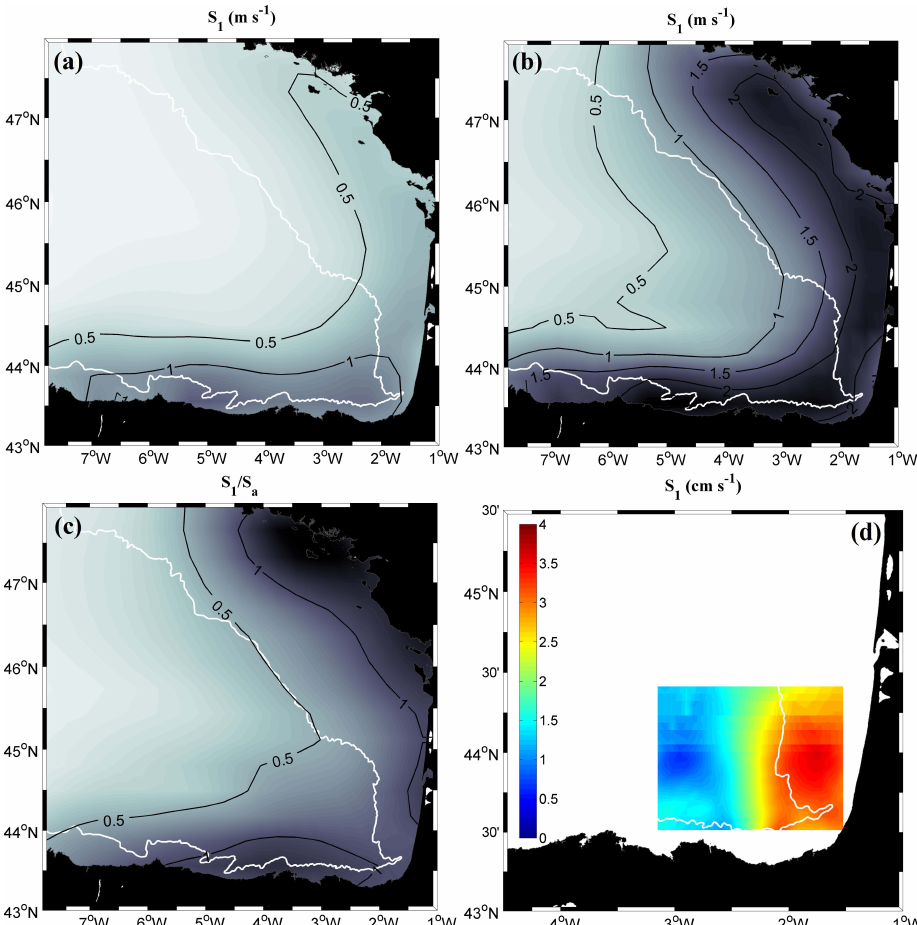
Fig. 3. The amplitude (ms − 1 ) of the diurnal ( S 1 ) harmonic of the surface wind speed from CFSR in the following: (a) wintertime (October to March) and (b) summertime (April to September) periods. (c) The ratio of the diurnal ( S 1 ) to the annual ( S a ) components is also presented for the period 1979–2010. (d) The amplitude (cms − 1 ) of the diurnal harmonic of the surface current speed derived from HF radar for the period 2009–2010. Bathymetric contour (solid white line) shows the 200-m